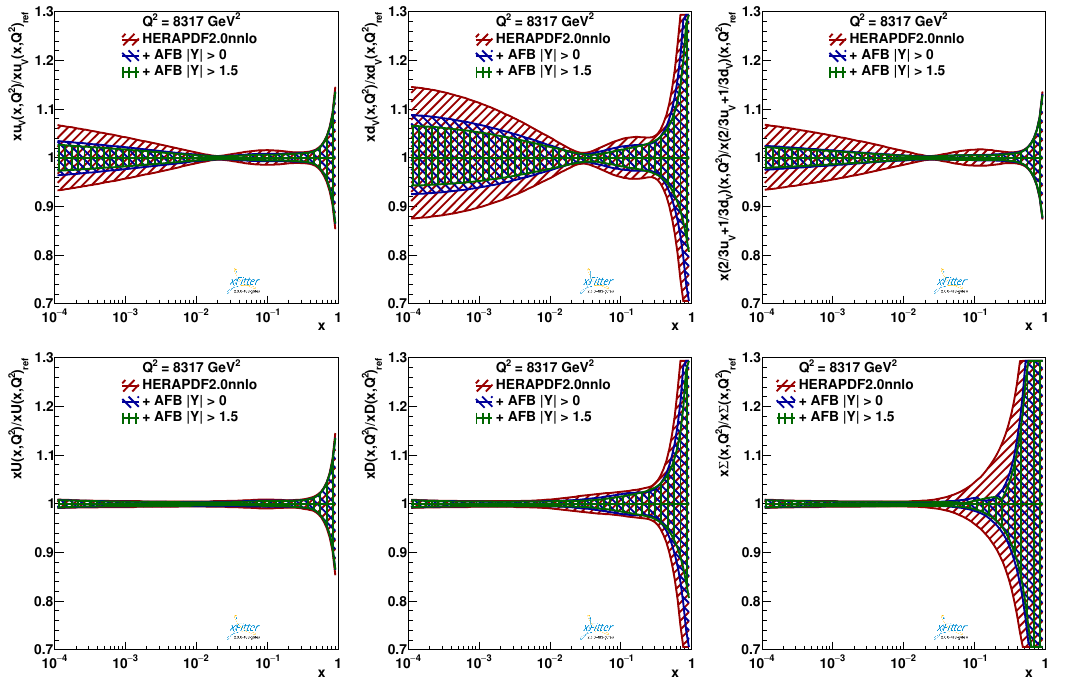
Figure 4 . Original (red) and pro(cid:12)led distributions for the normalised distribution of the ratios of (top row, left to right) u -valence, d -valence and ((2 = 3) u + (1 = 3) d )-valence and (bottom row, left to right) u -sea, d -sea quarks and ( u + d )-sea quarks of the HERAPDF2.0nnlo PDF set obtained using A (cid:3) pseudodata corresponding to an integrated luminosity of 3000 fb (cid:0) 1 , applying rapidity cuts of FB j y ‘‘ j > 0 (blue) and j y ‘‘ j > 1 : 5